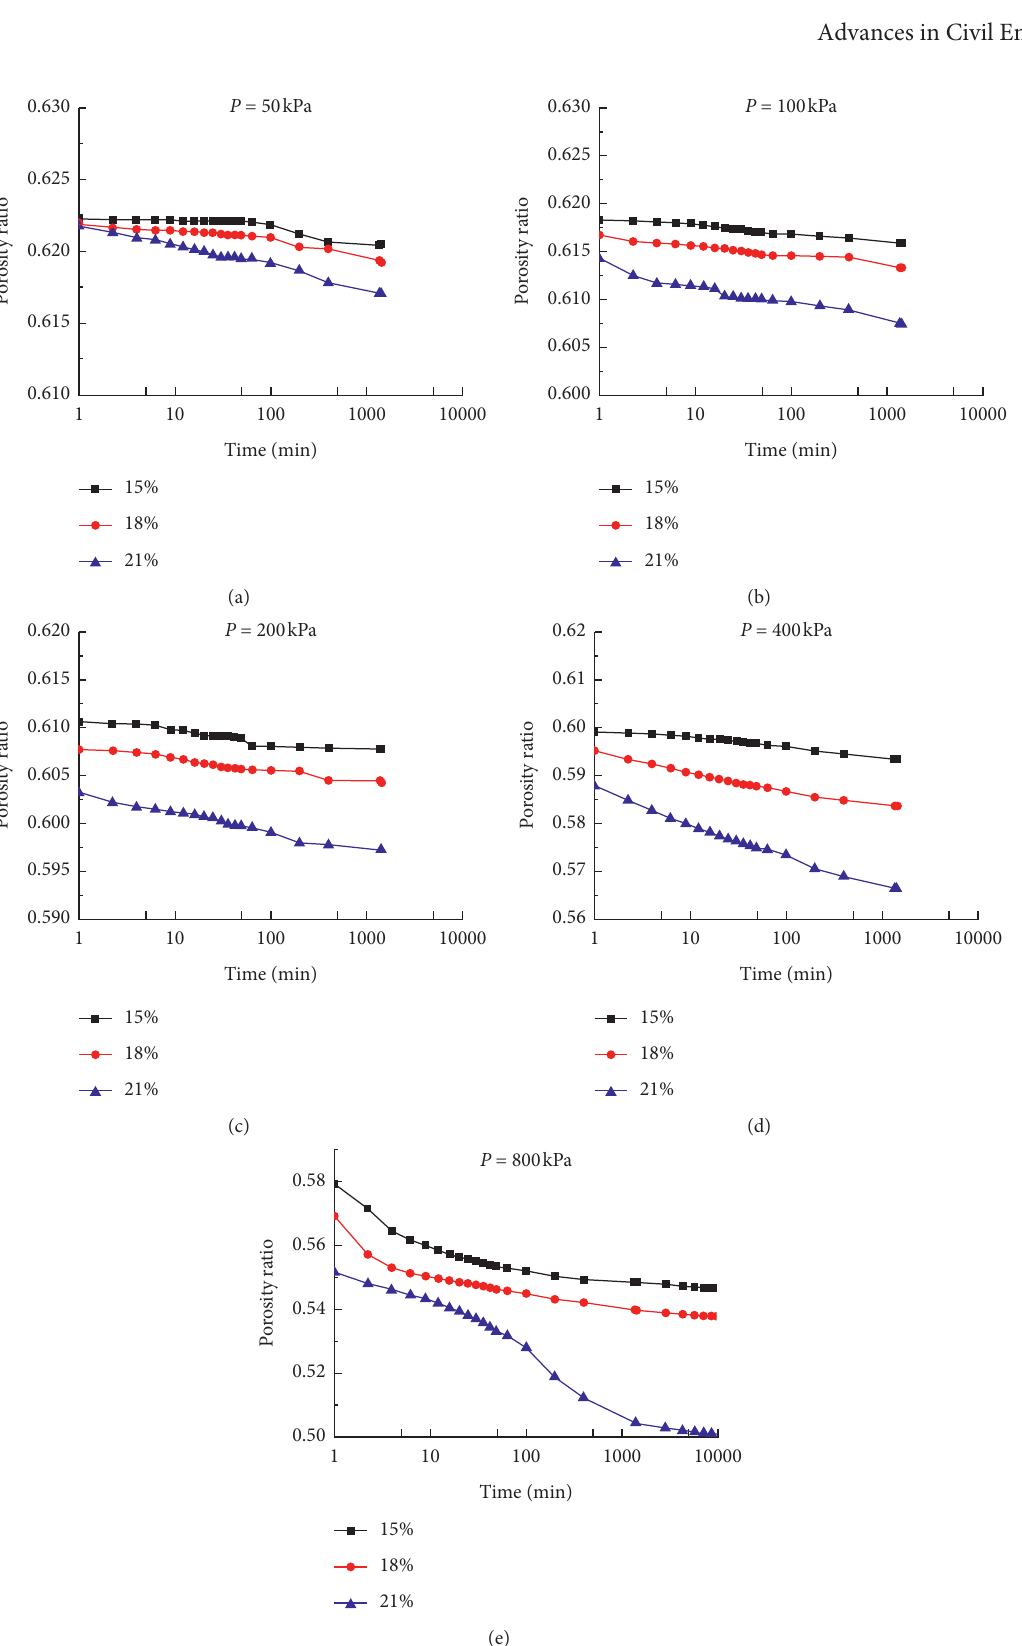
Figure 6: Consolidation test curves of expansive soil under different consolidation pressure ( P